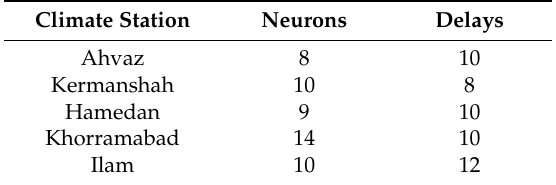
Table 4. Optimal number of hidden neurons and delays d for the NARX model at 5 KRB